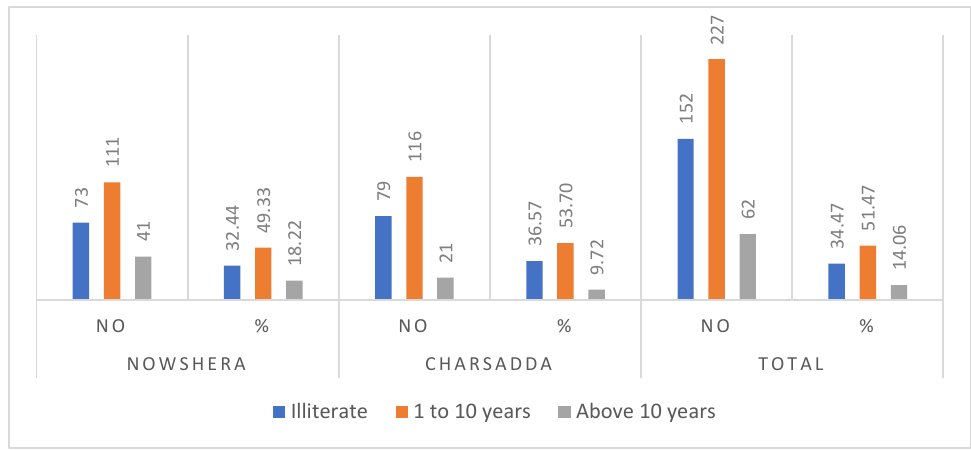
Figure 5. Flood risk perception varies based on the household head’s